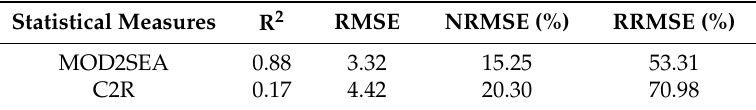
Table 5. Models performance evaluation Chla retrieval.